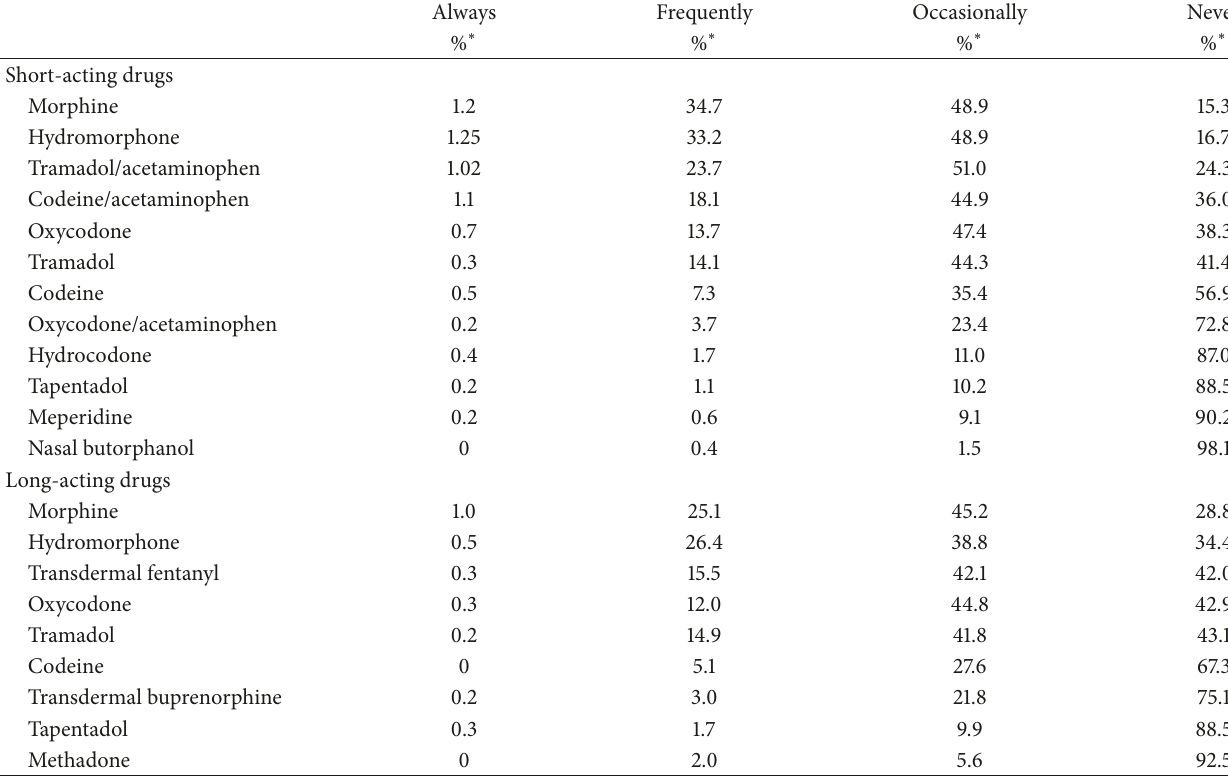
Table 3: Prescription opioid preferences.